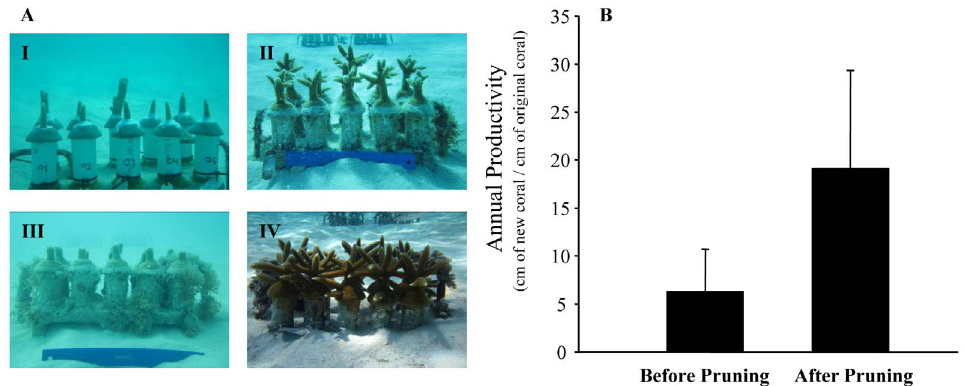
Figure 4. Effects of pruning on nursery corals. A) I: Fragments after initial collection, II: fragments 8 months after initial collection, III: fragments immediately after pruning (12 months after initial collection), IV: fragments 8 months after pruning. B) Annual productivity of fragments before pruning (after initial collection) and after pruning. Significant difference in productivity were found between groups (t test, p , 0.05).